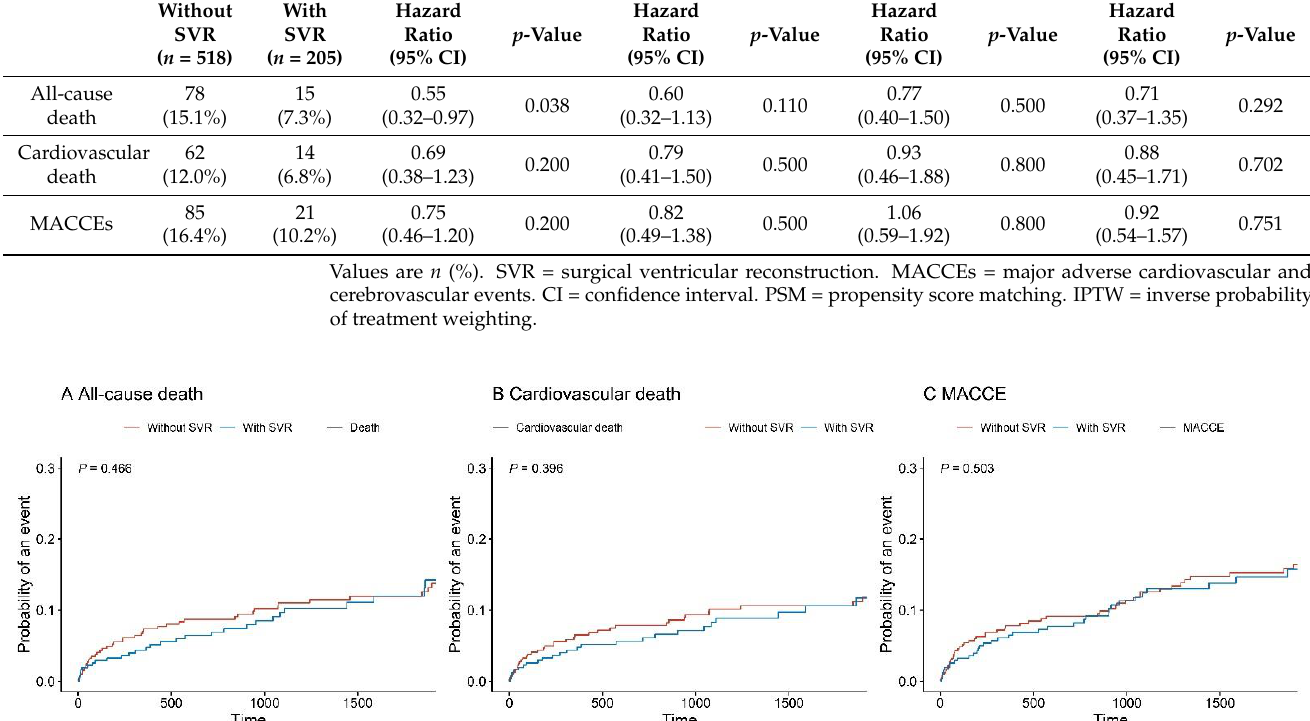
Table 2. Outcomes in the whole cohort and according to SVR group.